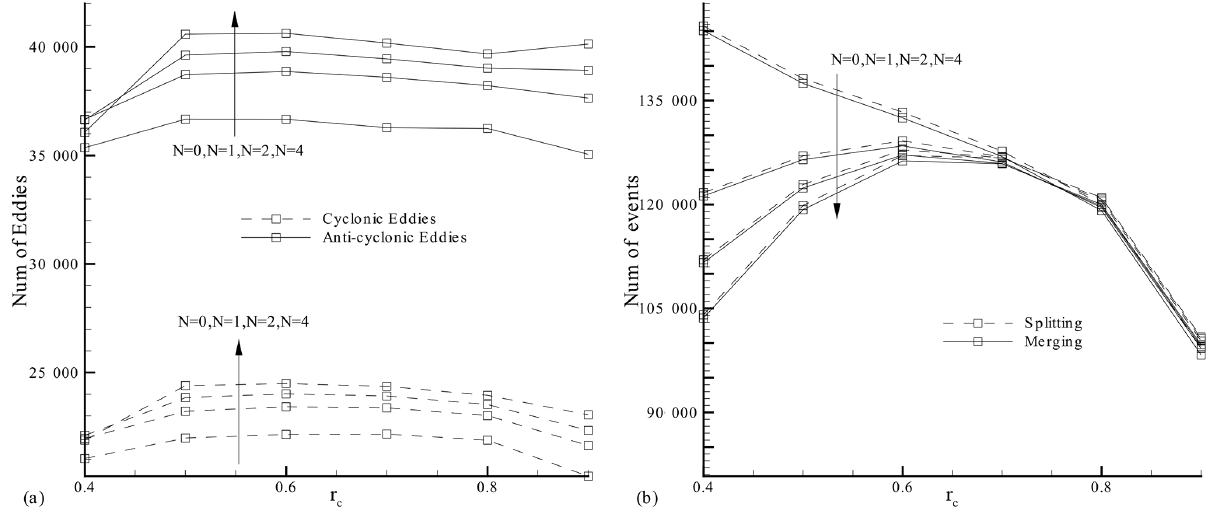
Figure 15. (a) Number of eddies (lifetime >30 days) vs. the critical value r c and look-ahead time N . (b) Number of merging and splitting events (lifetime >30 days) vs. the critical value r c and look-ahead time N